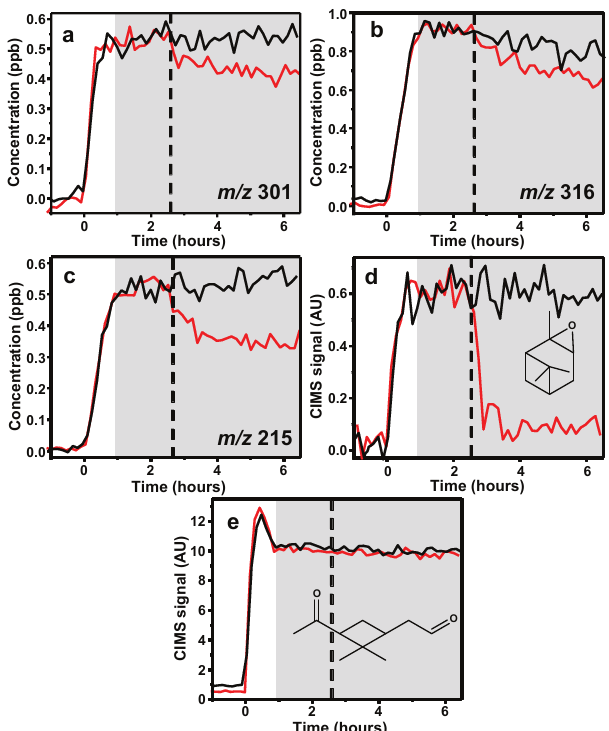
Fig. 9. CIMS traces of α -pinene OH oxidation under high-NO x conditions, photooxidation for ∼ 0.8 h, lights off and contents in the dark for ∼ 2 h followed by injection of ammonium sulfate seed (black) or ammonium sulfate and sulfuric acid seed (red). Shaded gray area is when the chamber was dark and the dashed line indi- cates when aerosol seed was